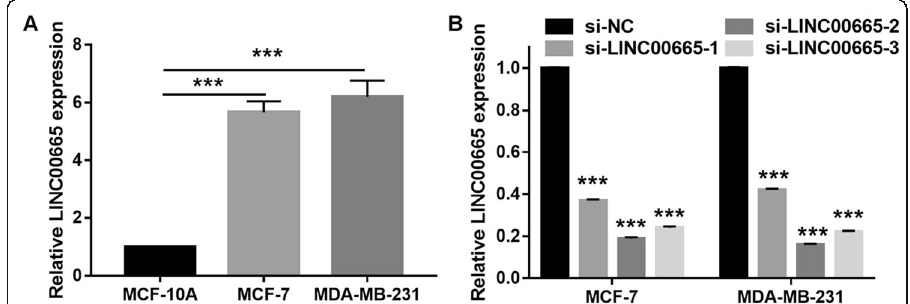
Fig. 2 LINC00665 expression in breast cancer (BC) cells. a LINC00665 knockdown efficiency in BC cells and in normal cells, as measured by performing quantitative reverse transcription-polymerase chain reaction (qRT-PCR) analysis. b LINC00665 knockdown efficiency, as measured by qRT-PCR, 48 h after transfection. *** P <